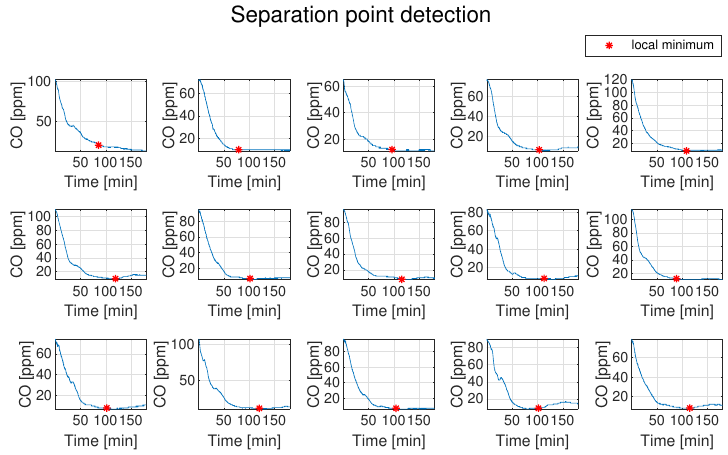
Figure A5. The detection of the separation point—Part II.